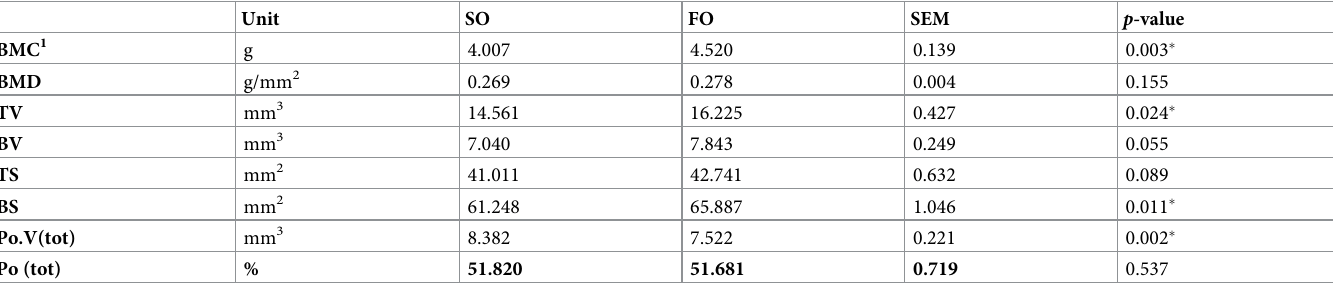
Table 6. Metaphysis microstructure of tibia on day 18 embryo.